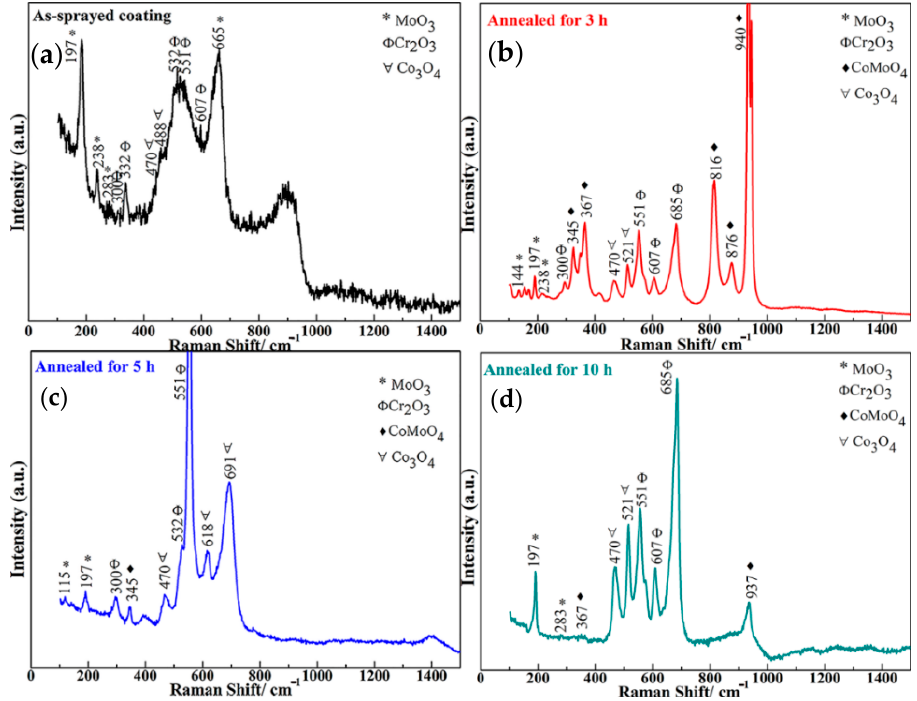
Figure 15. Raman patterns of the worn surfaces of as-sprayed CoMoCrSi coating ( a ) and coatings annealed for 3 h ( b ), 5 h ( c ), and10 h ( d ).